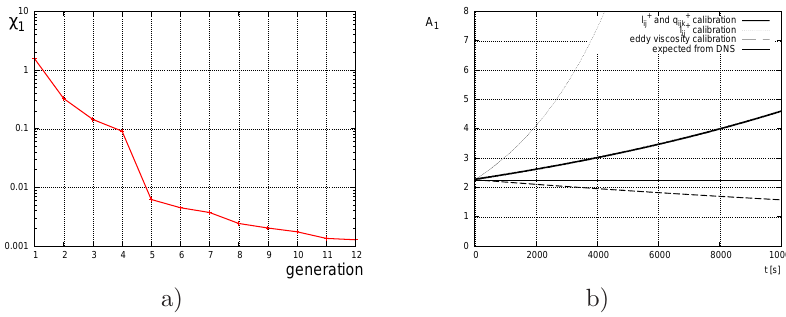
given time frame.